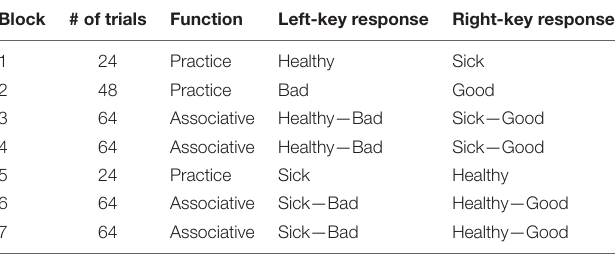
TABLE 1 | Block sequence in the Implicit Association Test (IAT). Block # of trials